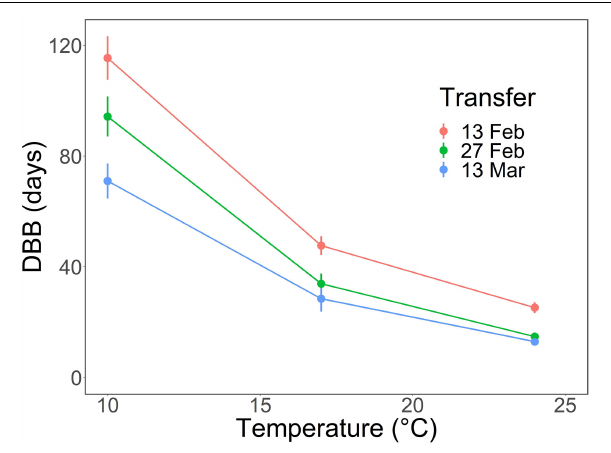
FIGURE 2 | Effects of air temperature on days to bud burst, DBB (mean ± SE), of first-year pecan seedlings in the spring experiment. The transfer dates indicate the time when the seedlings were transferred from the outdoor natural overwintering conditions to the three growth chambers with respective forcing temperatures of +10, +17, and +24 ◦ C. Note that the phenological event observed was leaf-out, but that the concept “bud burst” is used here as a generic one facilitating the use of the standard index DBB.